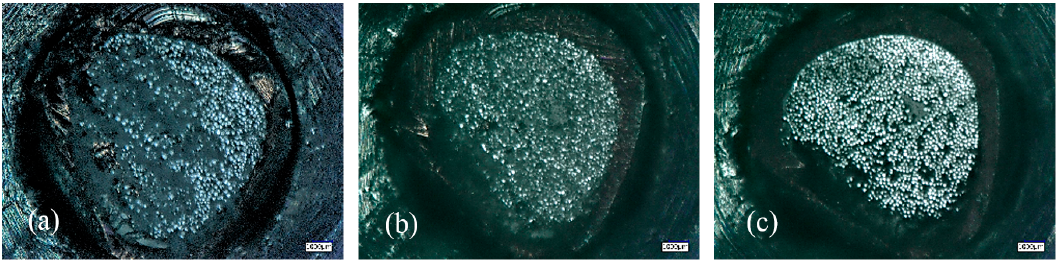
Figure 2. Microscope images of ( a ) a fibre bundle held together after cutting, and ( b ) 30-µm and ( c ) 0.2-µm fineness polishing.